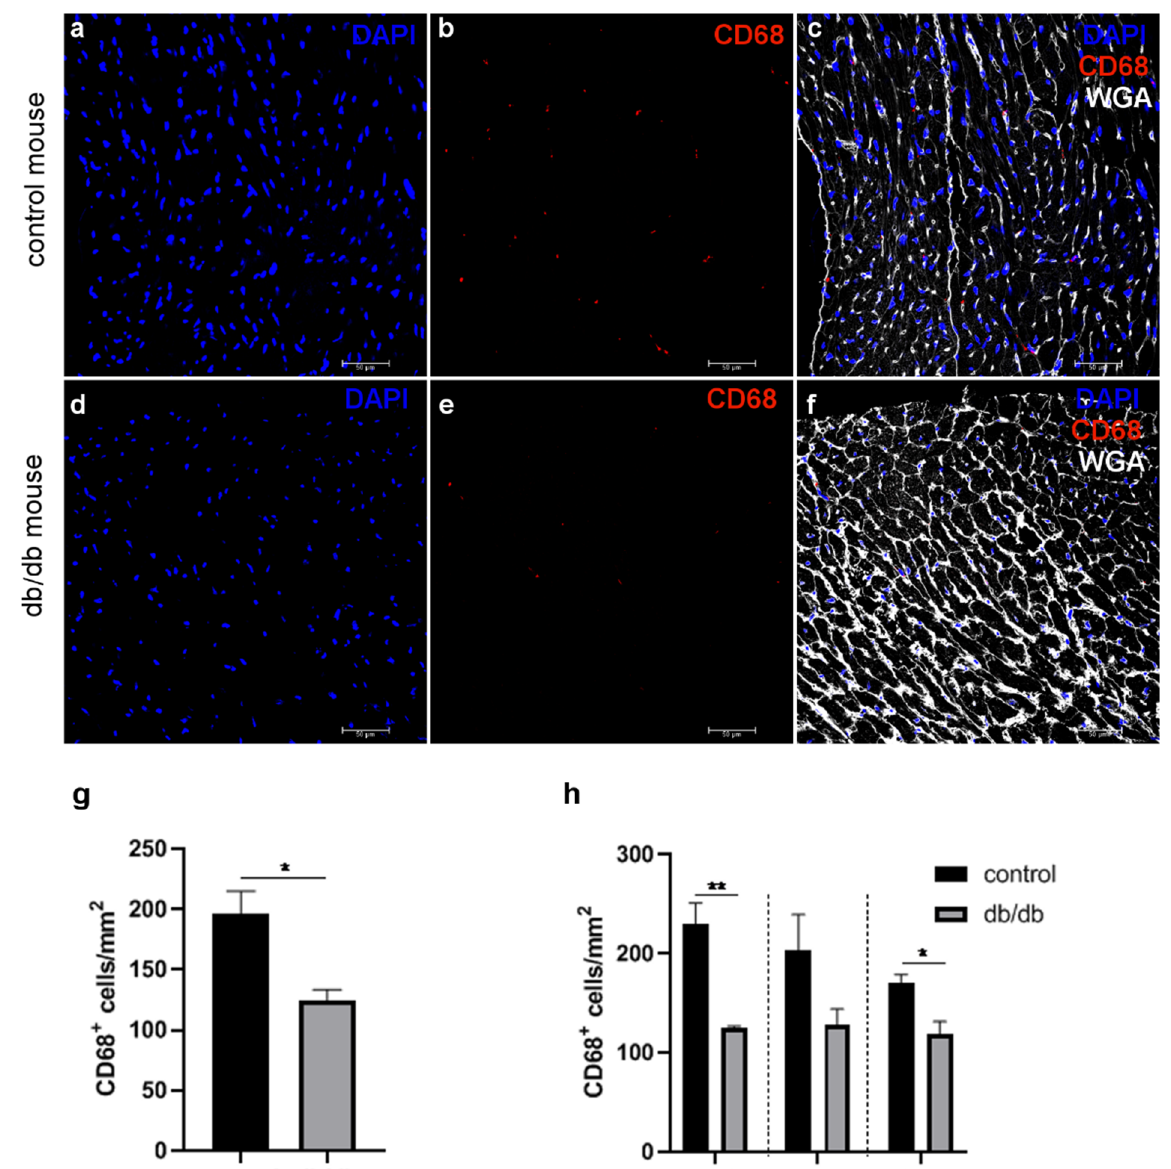
Figure 2. Confocal microscope analysis of macrophage density in the LV of control ( a – c ) and db/db ( d – f ) mice. Macrophages were visualized with anti-CD68 antibody. WGA (wheat germ agglutinin) was used to mark microvessels and cardiac myocyte boundaries. Figures were chosen among at least three independent stainings; the number of CD68 positive macrophages per mm 2 in whole ( g ) and in specific areas of heart ( h ) was calculated. Data are expressed as mean number of cells per area (mm 2 ), calculated within three independent stainings and 10 randomly selected regions of interest per staining; RV—right ventricle, LV—left ventricle, S—interventricular septum. * p < 0.05, ** p < 0.01.